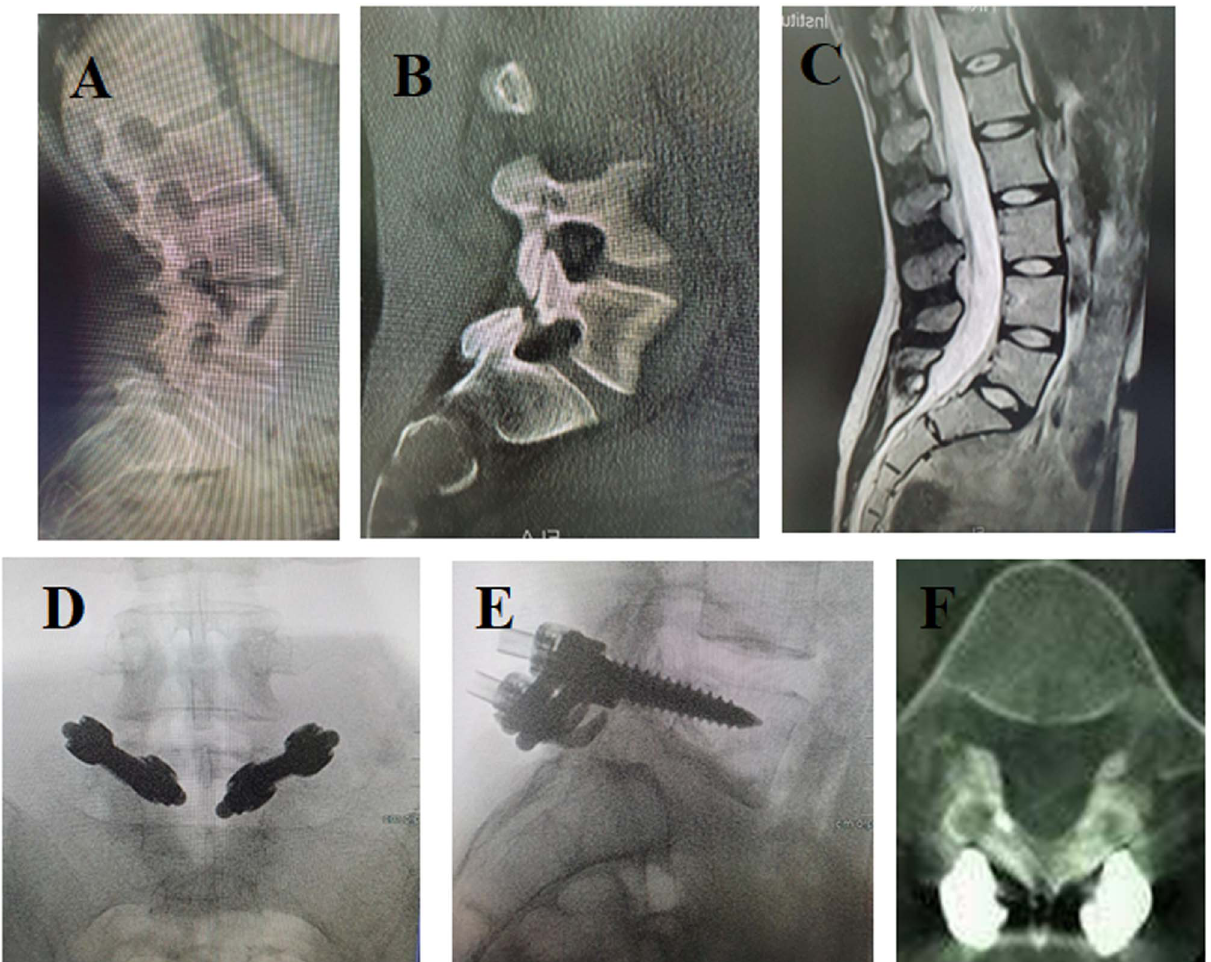
Figure 1. Twenty-six years old female with symptomatic spondylolysis performed pars repair after failed conservative treatment for 6